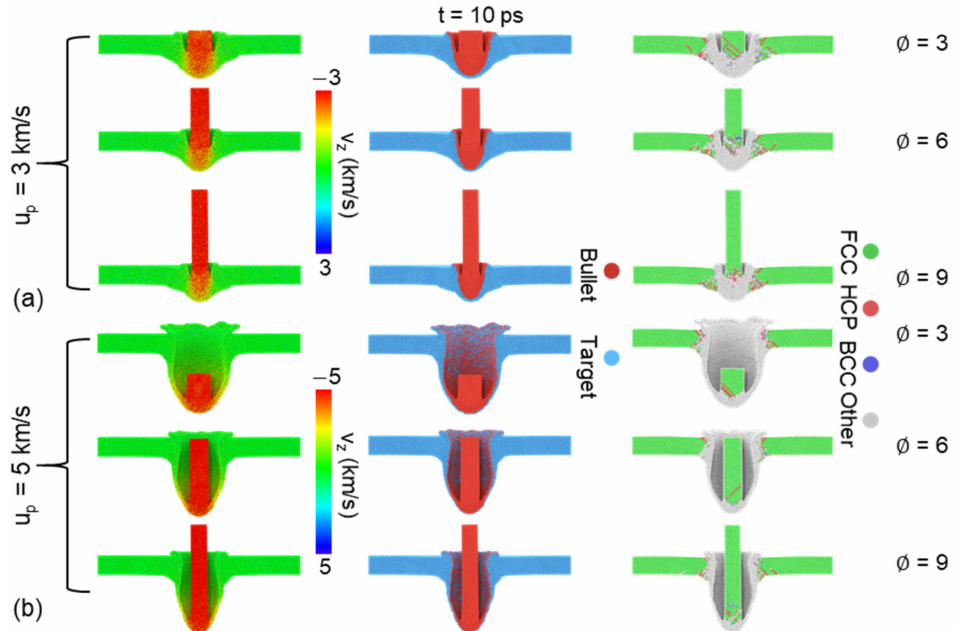
Figure 5. Atomic configurations at 10 ps for different ∅ at the case of ( a ) u p = 3 km/s and ( b ) u p = 5 km/s. Atoms are colored by velocity along impact direction (first column), matter distribu- tion (second column) and microstructure recognized by adaptive-CNA method (third